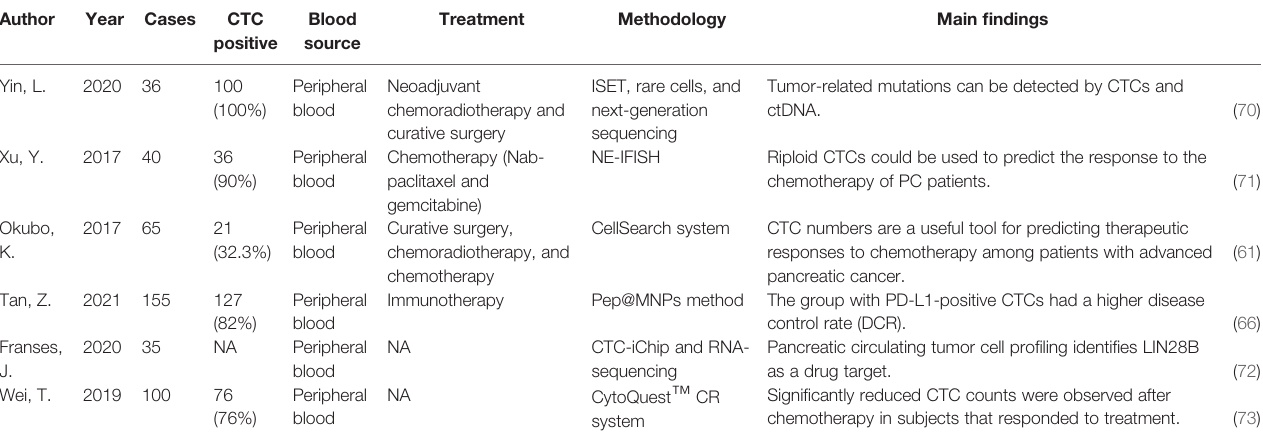
TABLE 2 | Role of CTCs for pancreatic ductal adenocarcinoma (PDAC)